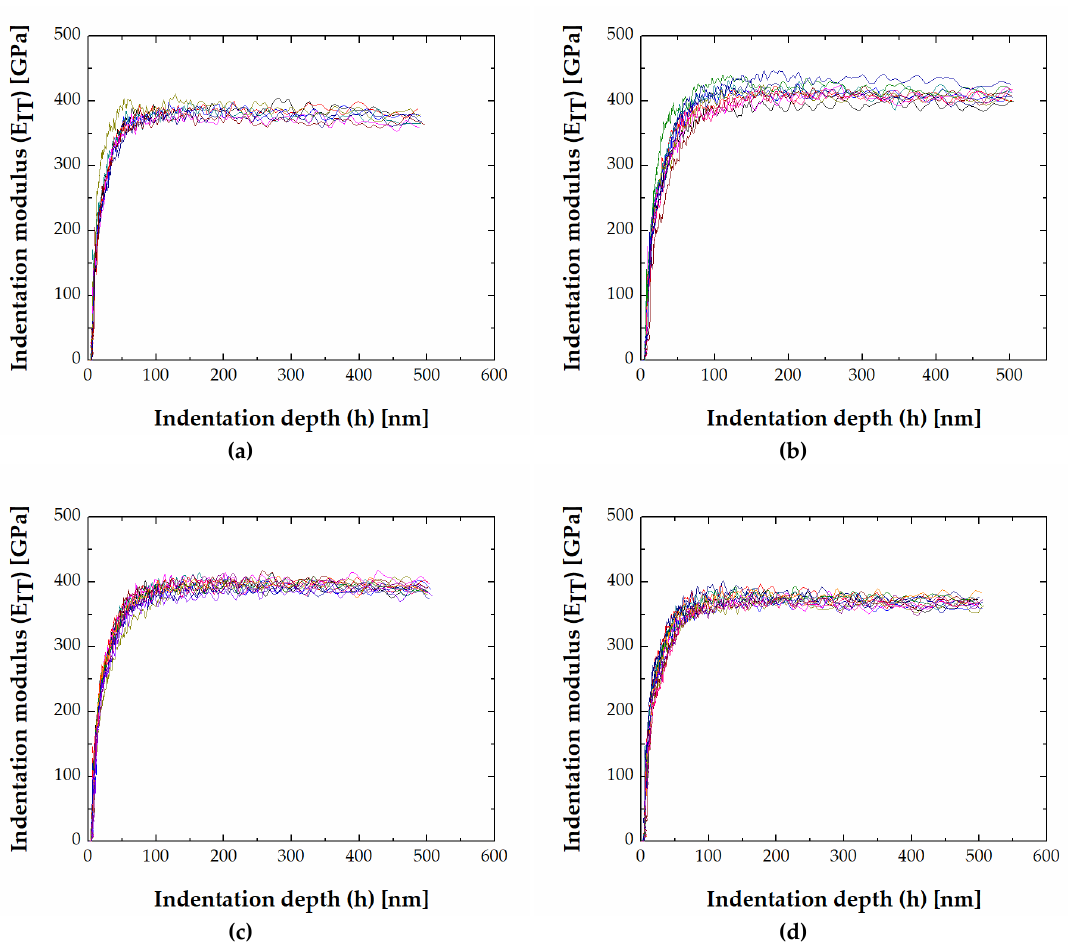
Figure 10. Indentation modulus vs. depth ( a ) FeB in 39.7 Fe–33 B–27.3 C, ( b ) MB in 51 Fe–39 B–10 Mn, ( c ) Fe 2 B in 50 Fe–40 B–10 Cr, ( d ) Fe 2 B in 50 Fe–41 B–9 V (alloy 14).